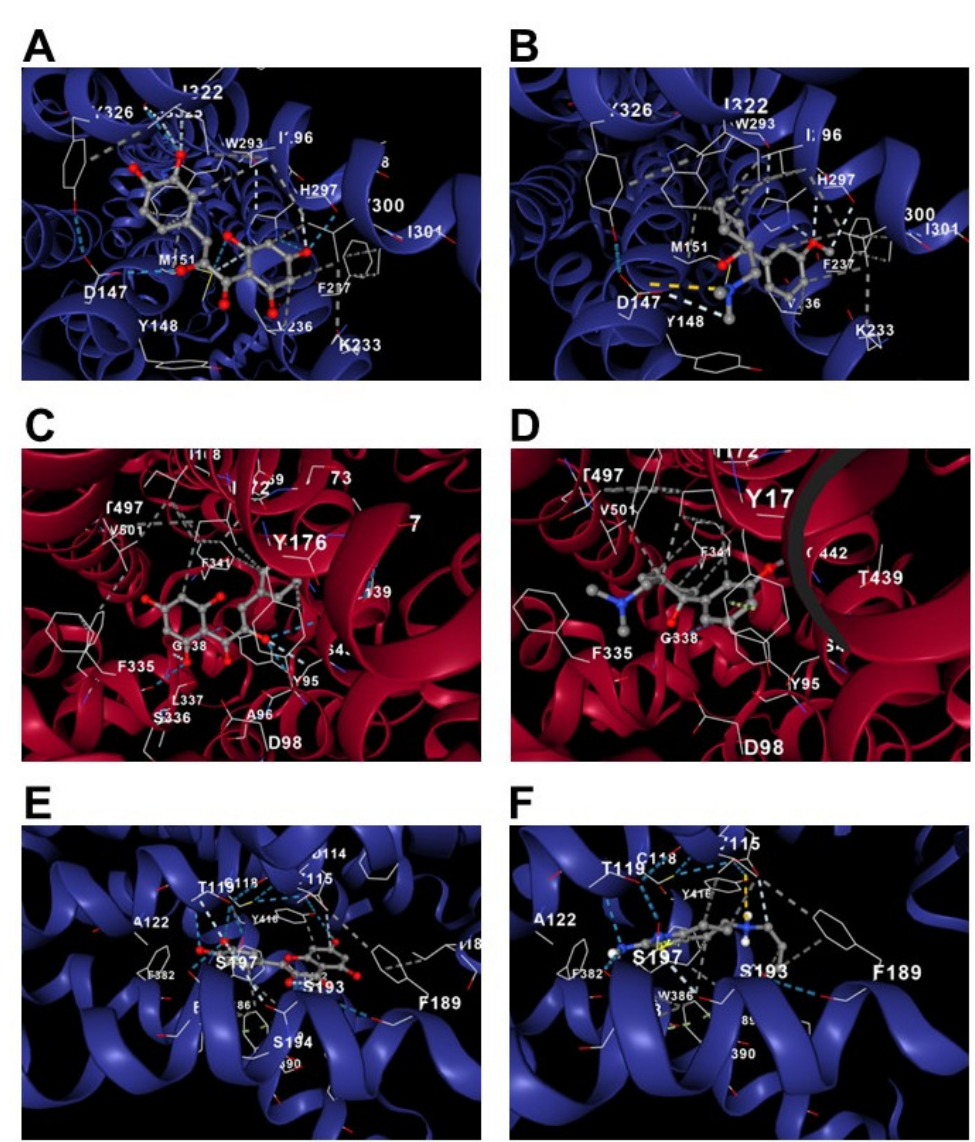
Figure 9. In silico evaluation of the interaction of quercetin with the µ -opioid receptor ( A ), serotonin transporter ( C ), and D 2 dopamine receptor ( E ) in comparison with the interactions of the tramadol with µ -opioid receptor ( B ), serotonin transporter ( D ), and pramipexole with D 2 dopamine receptor ( F ). It is observed that quercetin– µ -opioid complex shared 13 steric interactions with tramadol– µ -opioid complex (ASP114, VAL115, CYS118, THR119, ALA122, PHE189, SER193, SER197, PHE382, TRP386, PHE389, PHE390, HIS393, and TYR416) ( A , B ). The quercetin–serotonin transporter complex shared 5 steric interactions with the tramadol–serotonin transporter complex (ILE172, TYR176,